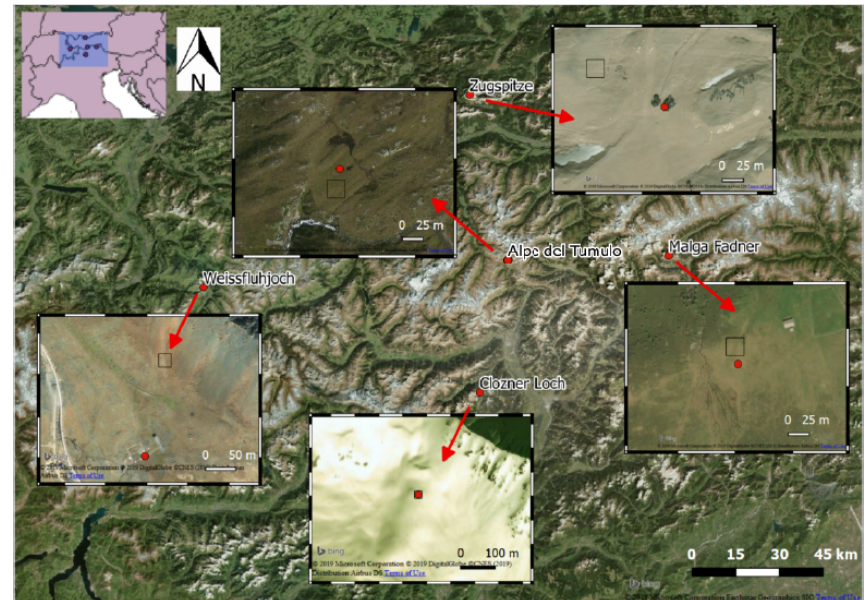
Figure 3. Overview map with the five stations used for the presented study (© 2019 Microsoft Corporation, © 2019 Digital Globe, © CNES (2019) Distribution Airbus DS). The red points indicate the exact location of the stations. The black squares indicate the S-1 footprints. The footprints were selected in order to minimize any possible interference of the EM wave with the homemade structures but maintaining a certain correlation with the in situ measurements. The panoramic images give an idea about the land cover type and the topography around the stations. Table 2. Details of the meteorological and snow parameters measured at each station. Wind velocity (VW), wind direction (DW), air temper- ature (TA), relative humidity (RH), snow depth (HS), snow temperature at different depths (TS), surface temperature (TSS), soil temperature (TSG), incoming shortwave radiation (ISWR), incoming longwave radiation (ILWR), outgoing shortwave radiation (OSWR), snow water equivalent (SWE), snow density (DS), liquid water content (LWC) and ice content (IC). Station Latitude,